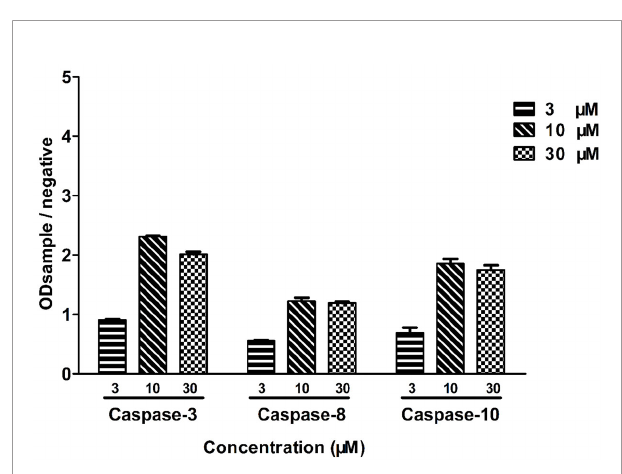
FIGURE 6 | Leiocarpin E-7 ′ -monoacetate induced-apoptosis was caspase- dependent. SW1116 cells were treated with leiocarpin E-7 ′ -monoacetate (3, 10, and 30 m M) for 8 h. Data are presented as means ± SEM ( n